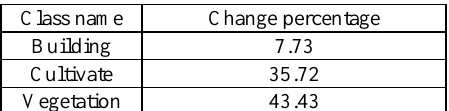
Table 5. Percentage of changed areas.